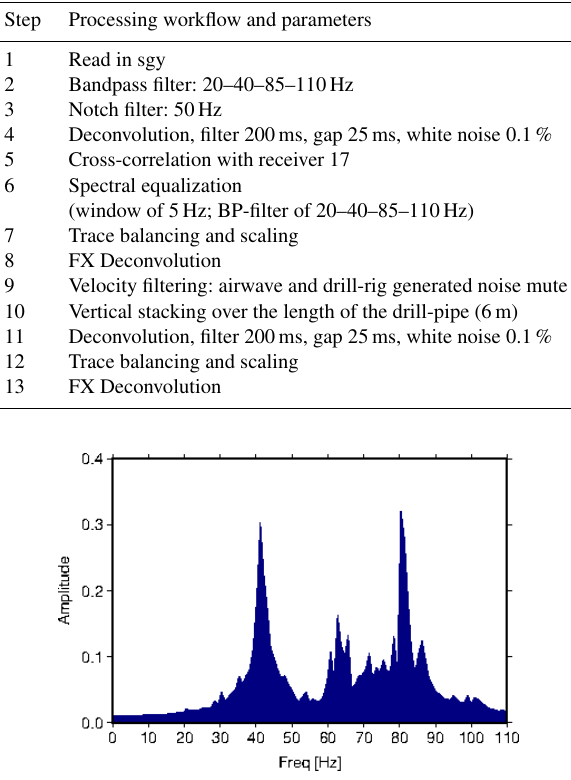
Figure 3. Amplitude spectra after cross-correlation and before the application of spectral equalization (see Table 1) showing high- amplitude mono-frequency